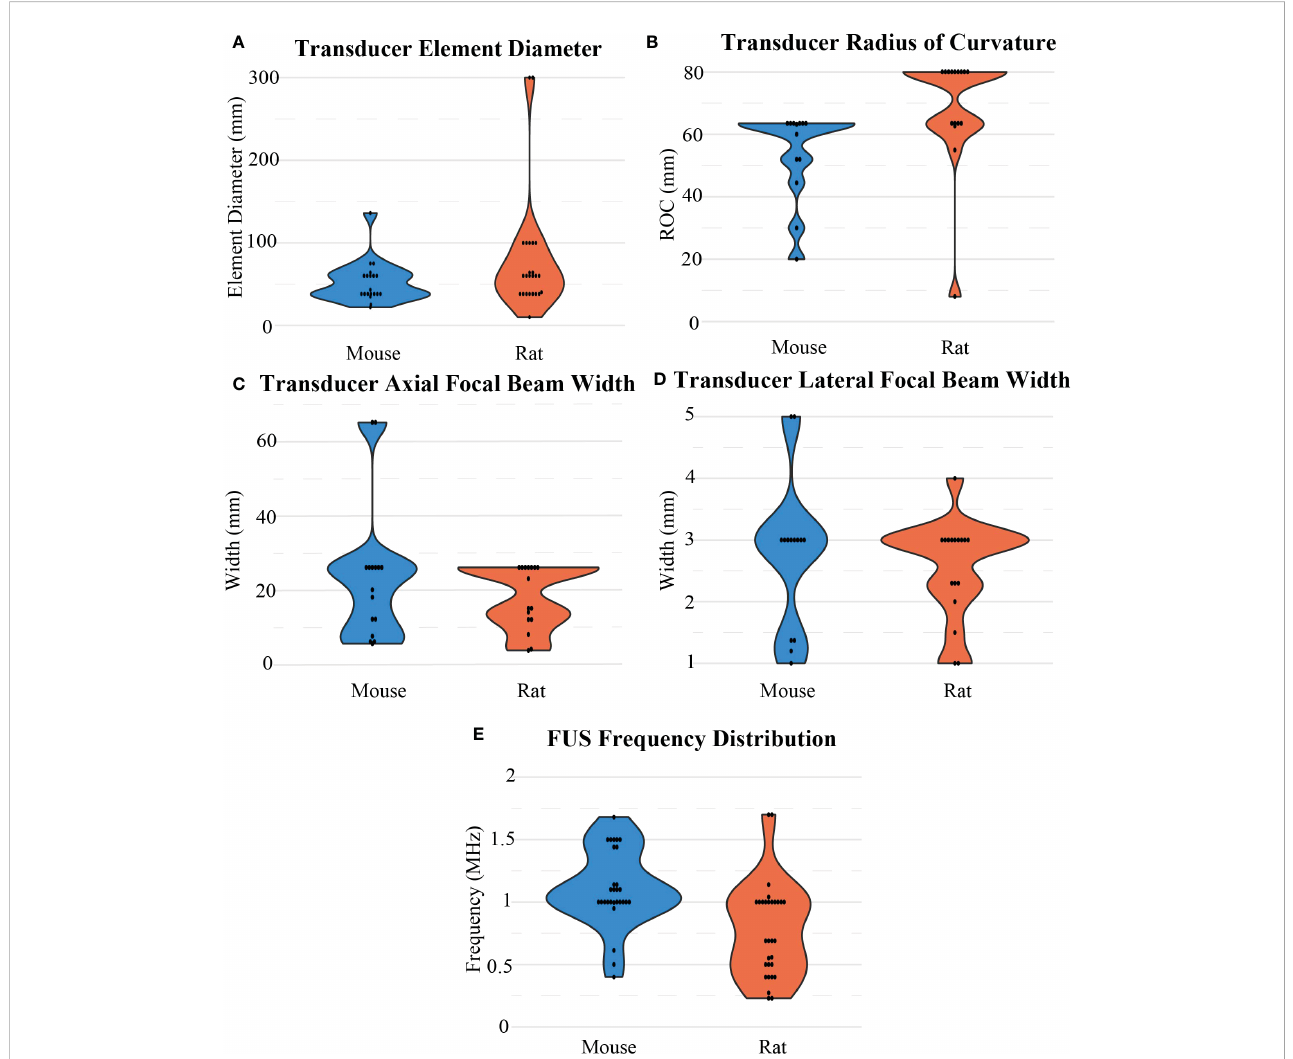
FIGURE 7 Distribution of FUS transducer properties for BBB opening experiments for mouse and rat models including (A) transducer element diameter, (B) transducer radius of curvature, (C) axial and (D) lateral widths of a focal region, and (E) FUS